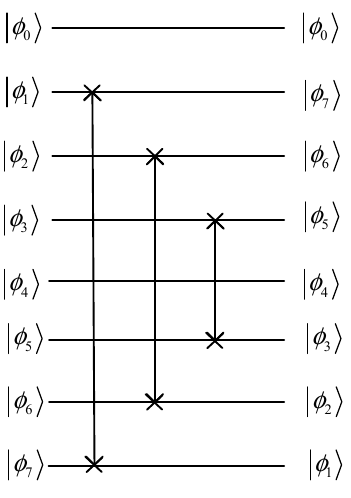
Figure 8. A circuit for the 2 QFT . Thus, the 2 QFT for quantum state α can be expressed as 1. The third power of the QFT , which is equivalent to the inverse operation of the QFT , is also a unitary operator.